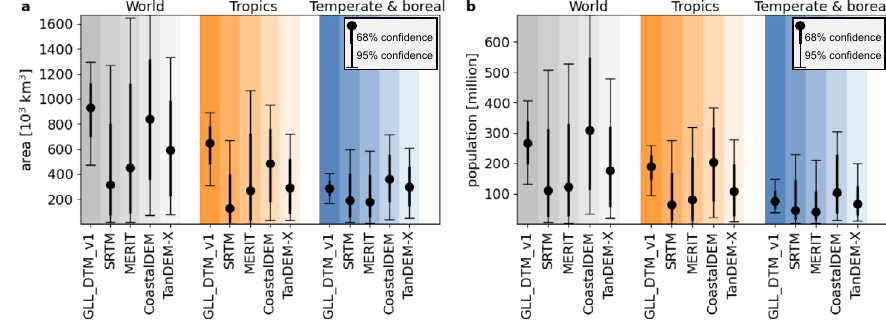
Fig. 3 Coastal lowland area and population below 2 m above mean sea level ( + MSL), with con fi dence levels at 68 and 95%; summary of Supplementary Data. a Areas calculated from different Global Digital Elevation Models (SRTM90 13 , MERIT 14 , CoastalDEM 15 and TanDEM-X 23 ) compared to GLL_DTM_v1 8 at 0.05-degree resolution, for countries ranked by land area greater than 12,000 km 2 below 2 m + MSL. For consistency, numbers are calculated within the SRTM coverage extent, between 60 N and 56 S. b Population data from ref. 22 .